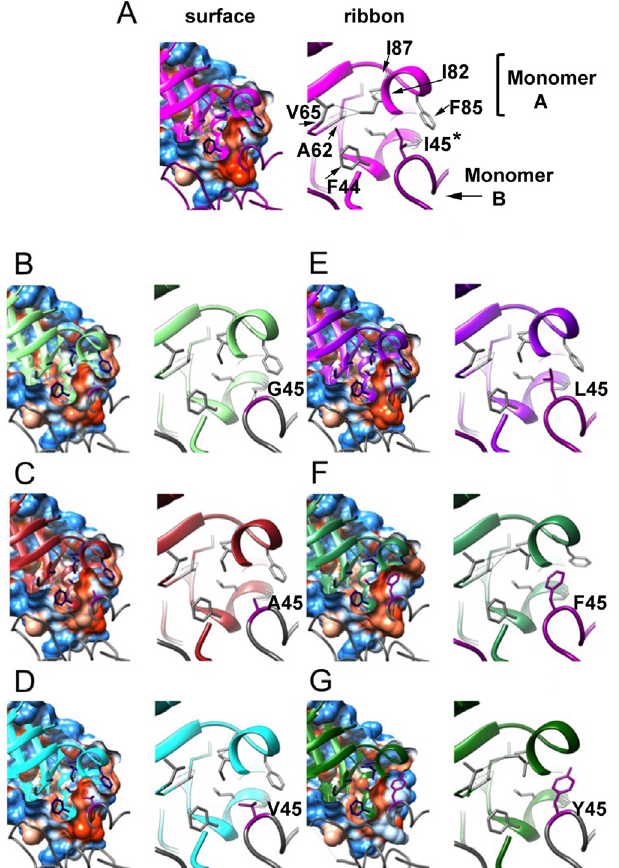
Fig 6. Crystal structures of TvTIM1 and point mutants at residue I45. Surface and ribbon representation of the ball and socket interaction at the dimer interface. Monomer A is represented as ribbons and monomer B is represented as coil. Residues of the socket (F44, A62, V65, I82, F85 and I87) of monomer A are shown in blue in the left panel and gray in the right panel, the ball residue (position 45) of monomer B is depicted in dark magenta in both panels. In the left panel , the cavity that is formed by residues of the socket is observed in a sliced view of the hydrophobicity surface of monomer A with the ball residue 45 of monomer B inside the cavity. Mutant I45G (B) shows a water molecule inside the cavity at H-bond distance from residues 45 and 46 of monomer B and residue 81 of monomer A. Right panel , a closer view of residues of the socket and the ball is shown. TvTIM1 structure (A) shows the most common rotamer for the side-chain of residue I82, whereas I45G (B), I45A (C), I45V (D) and I45L (E) mutants present the second frequent rotamer. I45F and I45Y enzymes display the third frequent rotamer for I82